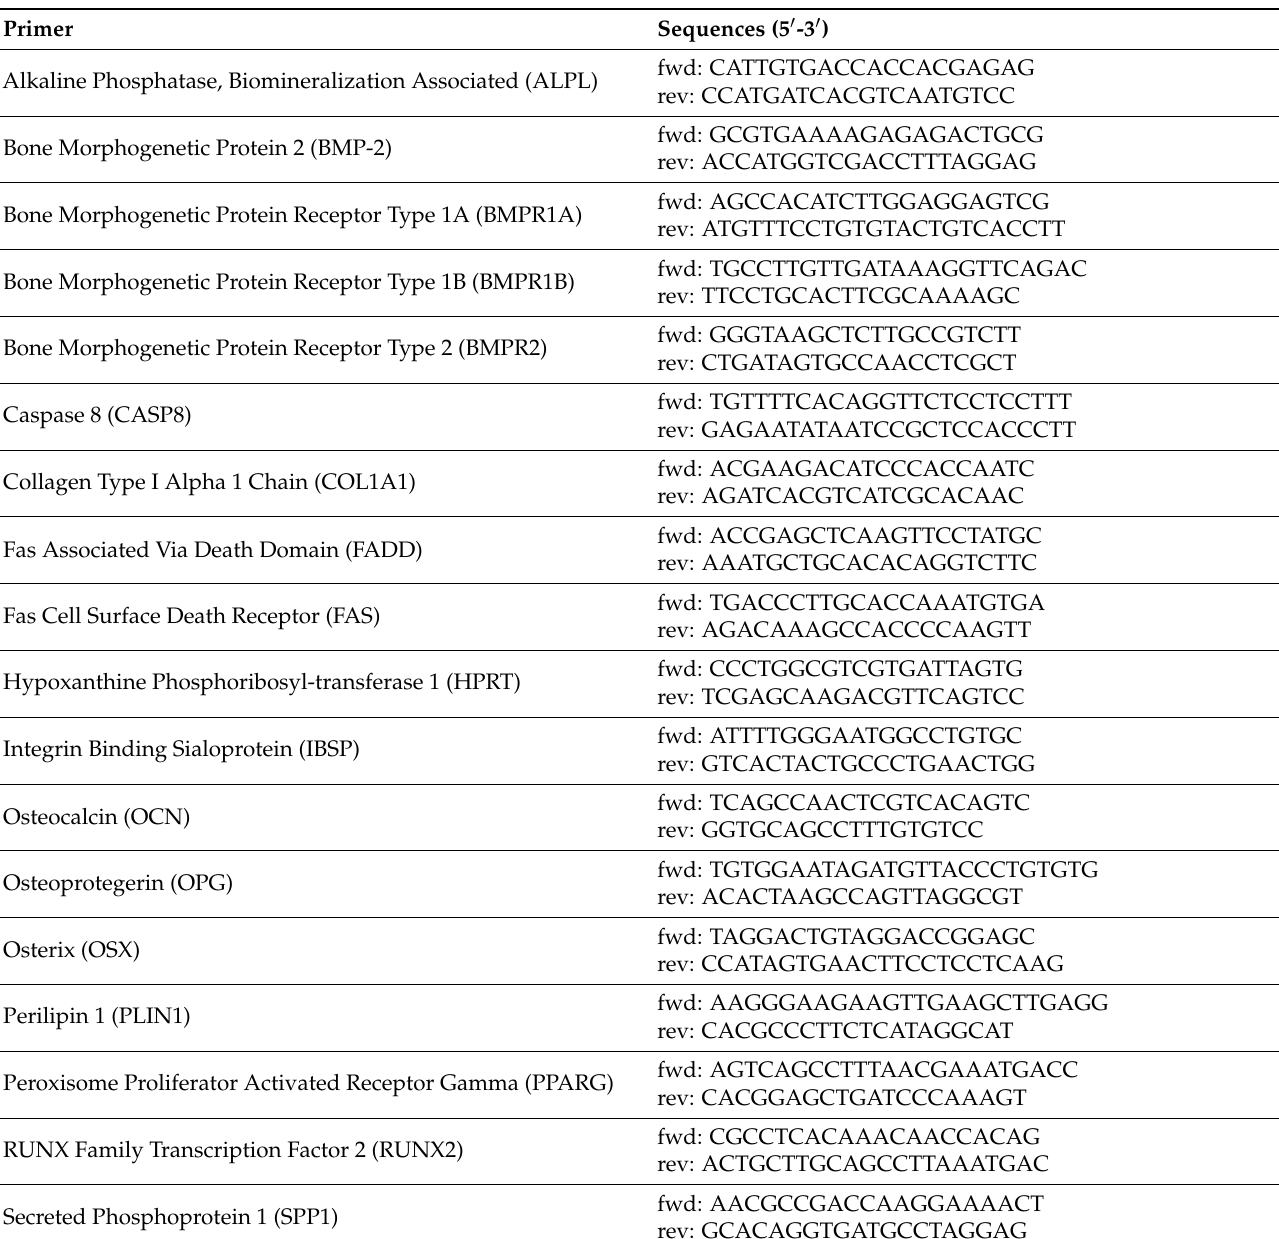
Table 1. Primer sequences for